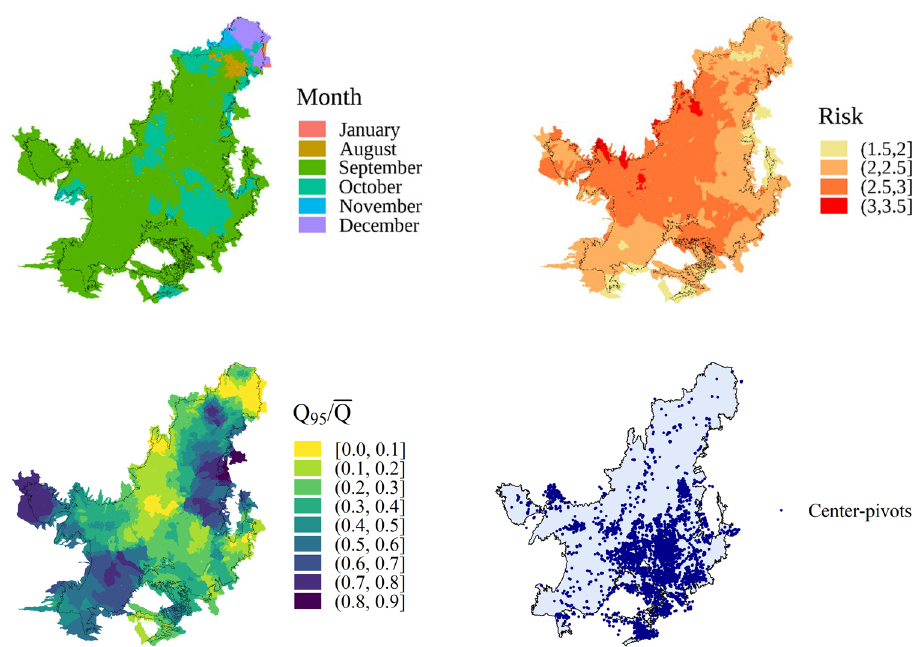
Fig. 8 In each ottobasin, the month represents the highest average risk of an increased pressure on the water availabil- ity and the average risk associ- ated with it